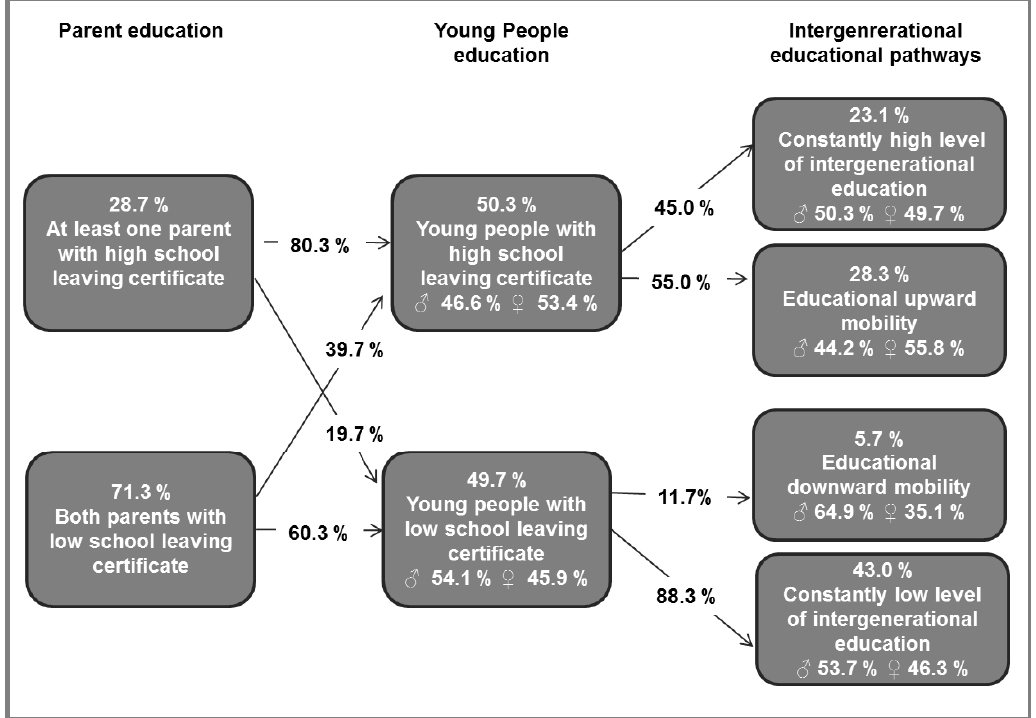
Figure 1. Intergenerational educational pathways: comparing the highest school-leaving certificates of young people and their parents.